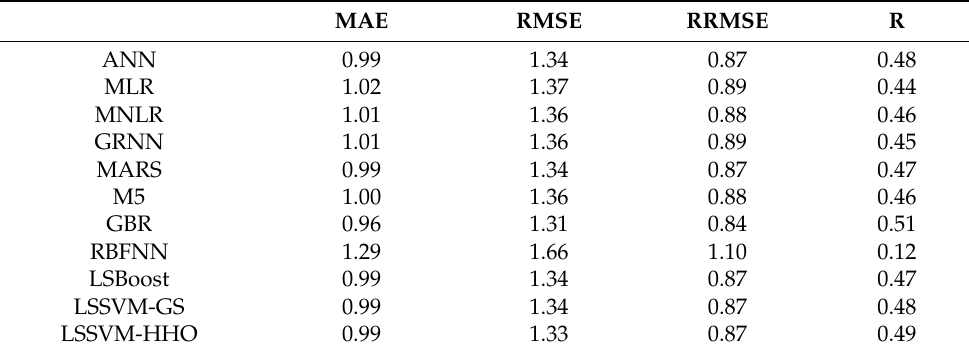
Table 3. Average results of the algorithms during the testing period at the sixteen